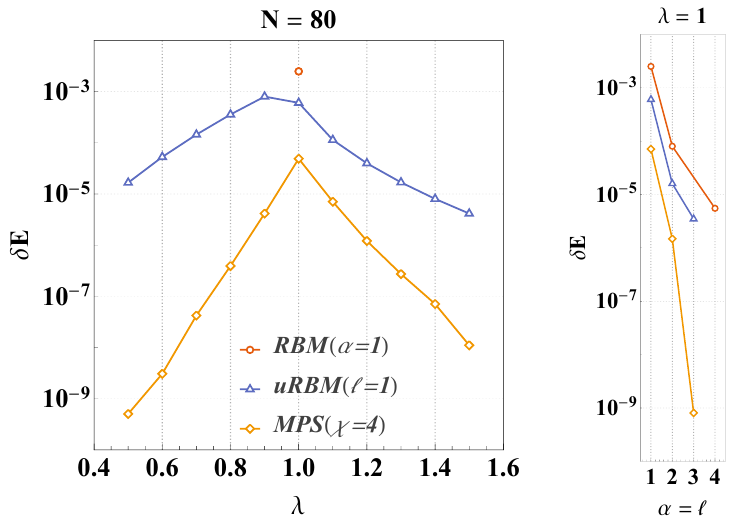
Figure 3: Relative error in the ground-state energy estimate for different many-body wave function representations. (left panel) We compare the uRBM with (cid:96) = 1 with respect to the canonical MPS with the same bond dimension ( χ = 2 (cid:96) + 1 = 4) as a function of the transverse field λ . (right panel) Scaling analysis of the energy error at the critical point, as a function of the hidden variable density α = (cid:96) (for RBM and uRBM) and analogous bond dimension χ = 2 (cid:96) + 1 (for the MPS). RBM (uRBM) representation reaches (overtakes) the accuracy of the MPS with χ = 4 only for α = 2 ( (cid:96) = 2); however, they remain above the estimate obtained with a canonical MPS with the same auxiliary dimension of the uRBM, i.e. χ = 2 (cid:96) + 1 =